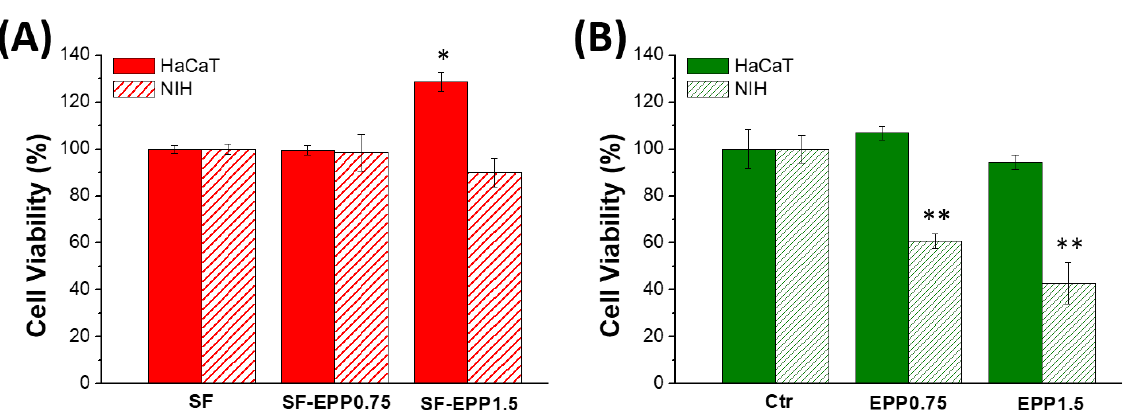
Figure 7 . MTT test carried out after 48 h of incubation on HaCaT and NIH cells plated on SF and SF-EPP films ( A ) and on cells treated with free EPP used at the same concentrations present on the films ( B ). Data represent mean ± standard deviation. Statistical analyses were performed using ANOVA followed by Tukey’s test. * p < 0.05, ** p < 0.01, denote significant differences with respect to the control.